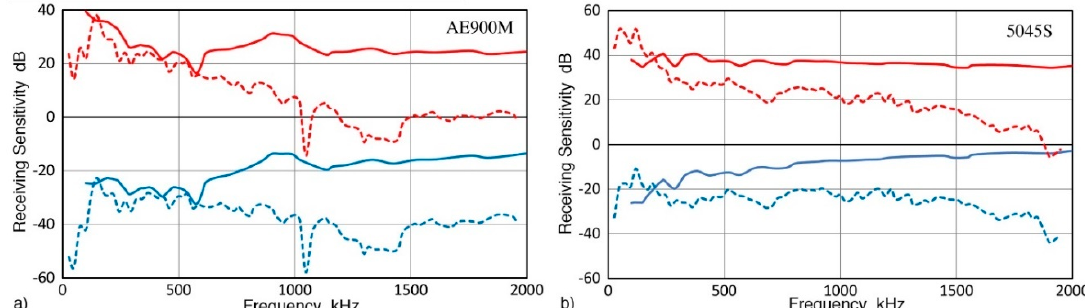
Figure 2. ( a ) Laser interferometric calibration results of Matsuda et al. [34,35]. NW (solid curve) and RW (dash curve) receiving sensitivities for AE900M sensor. Upper red curves are for the velocity sensitivity and the lower blue curves are for the displacement sensitivity. ( b ) 5045S sensor. Sensor types were identified with the assistance of the lead author, Y. Matsuda.